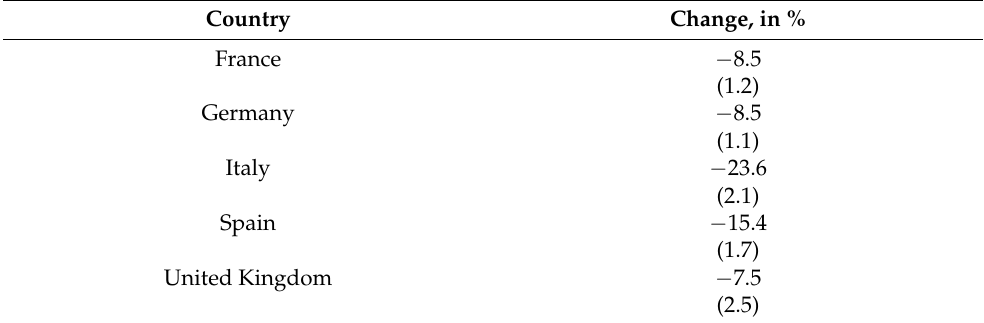
Table 1. Anticipated changes in the adjusted electricity consumption due to the COVID-19 pandemic.